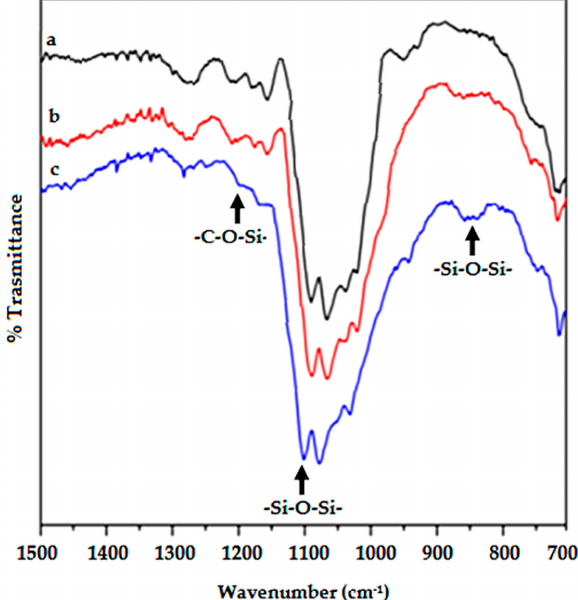
Figure 1. Fourier Transform Infrared (FTIR) spectra of ( a ) untreated (black line); ( b ) after two (red) and ( c ) five (blue) soaking/drying cycles.